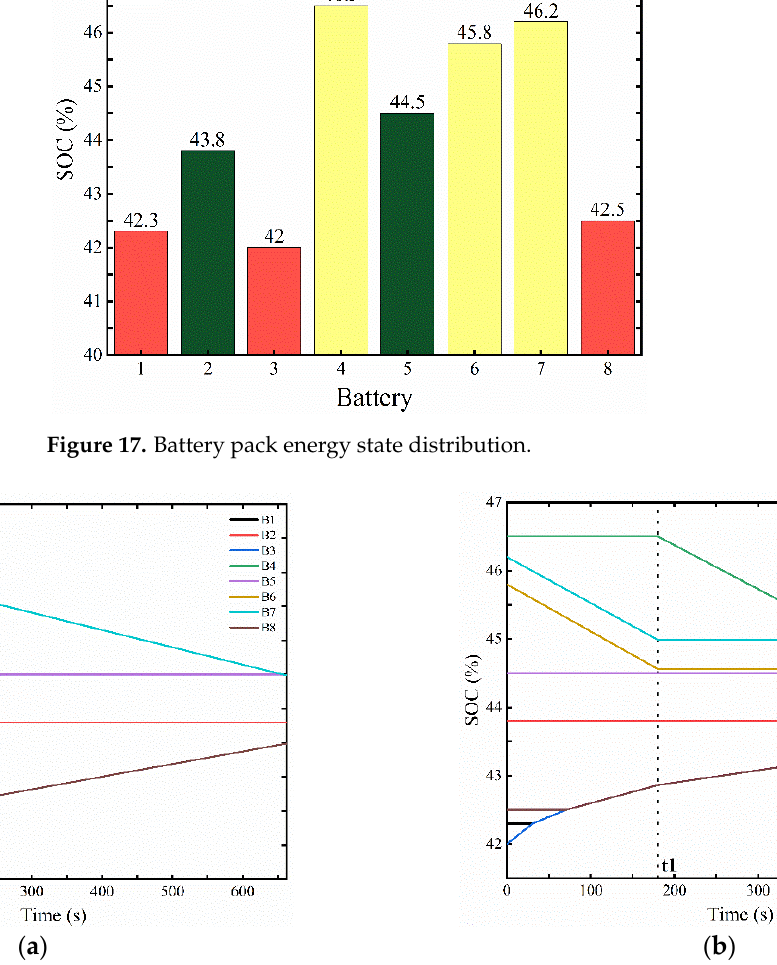
Figure 17. Battery pack energy state distribution.